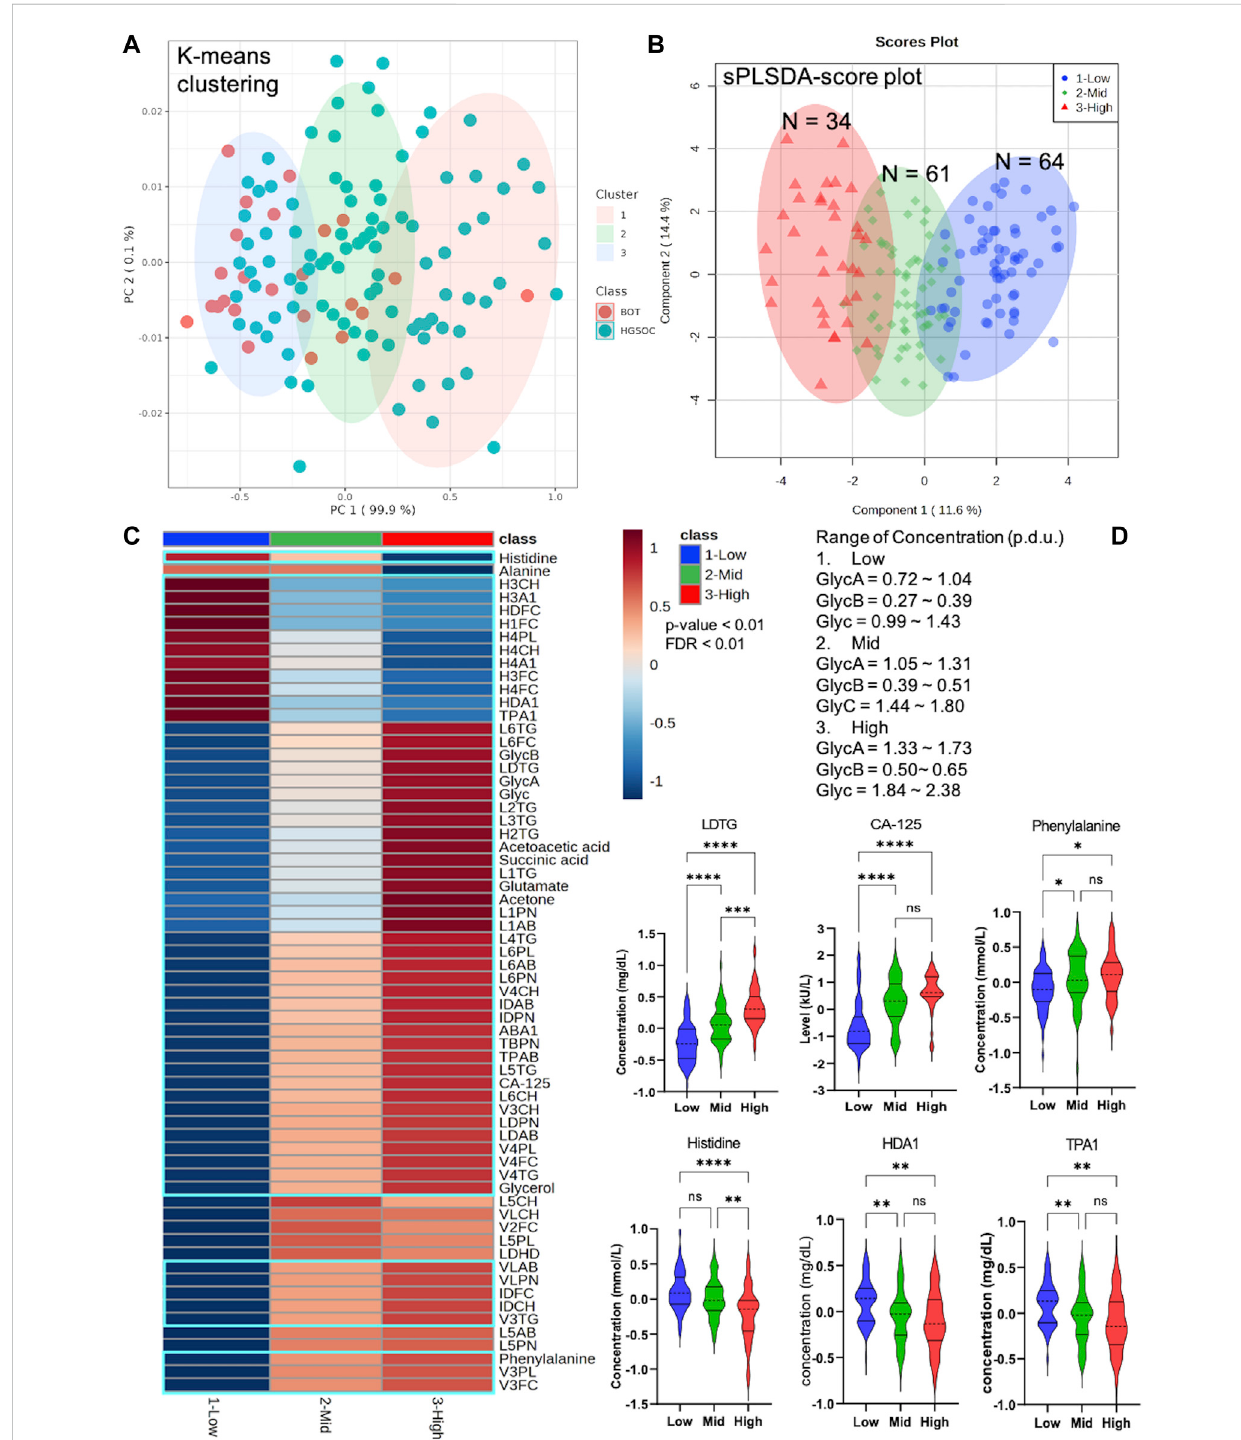
FIGURE 6 Uniquepatternofmetabolites,lipoproteins,andCA-125indifferentGlycclassesthatincludeborderlineovariantumor(BOT)andhigh-gradeserous ovarian cancer (HGSOC) with clinical stages. (A) K-means clustering based on NMR-based in fl ammatory concentration. (B) sPLSDA score plot with clear distribution of ovarian tumor and cancer at different in fl ammatory levels. (C) Heatmap displaying signi fi cantly altered metabolites, lipoproteins, and CA- 125 of ovarian tumor and cancer at different in fl ammatory concentrations ( p -value < 0.01 and FDR < 0.01). (D) Selected violin plots by comparative statistics showing signi fi cantly altered metabolites, lipoproteins, and CA-125 involved in in fl ammation ( q -value = * < 0.01, ** < 0.001, *** < 0.0001, and **** <